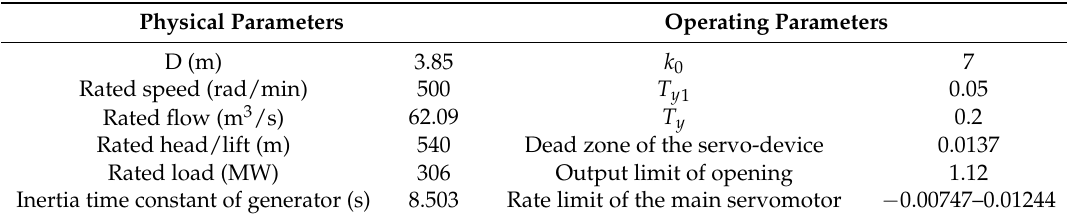
Table A5. Actual physical parameters and operating parameters of